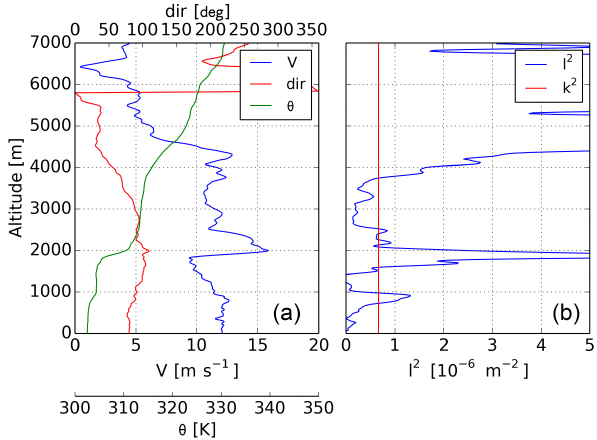
Figure 10. (a) Horizontal wind speed (blue), wind direction (red) and potential temperature (green) measured by a dropsonde launched at (26.6.13–22:05LT). (b) Derived Scorer parameter (blue) and approximate wave number corresponding to the observed waves (red).